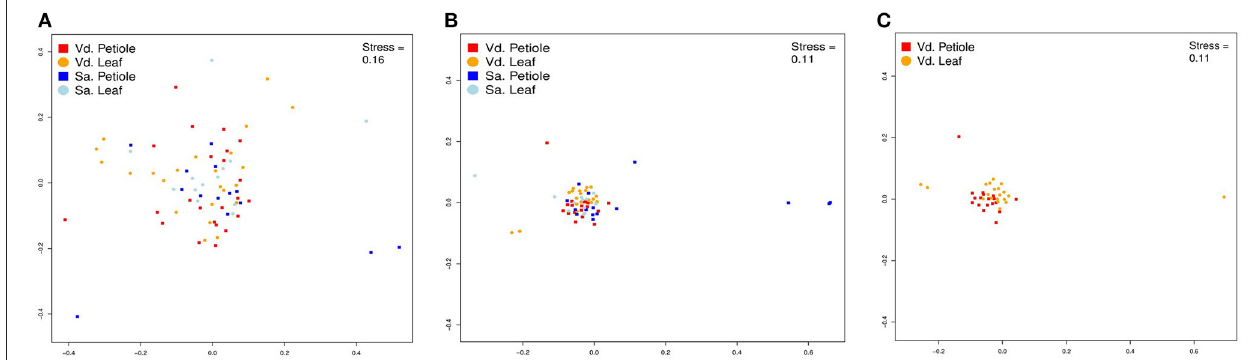
FIGURE 4 | Non-Metric Multidimensional Scaling (nMDS) of plots of fungal endophytic communities from Vochysia divergens (Vd) and Stryphnodendron adstringens (Sa). (A) NMDS plots based in genera level; (B) NMDS plots based in morphotype level; (C) NMDS plots based in morphotype level.